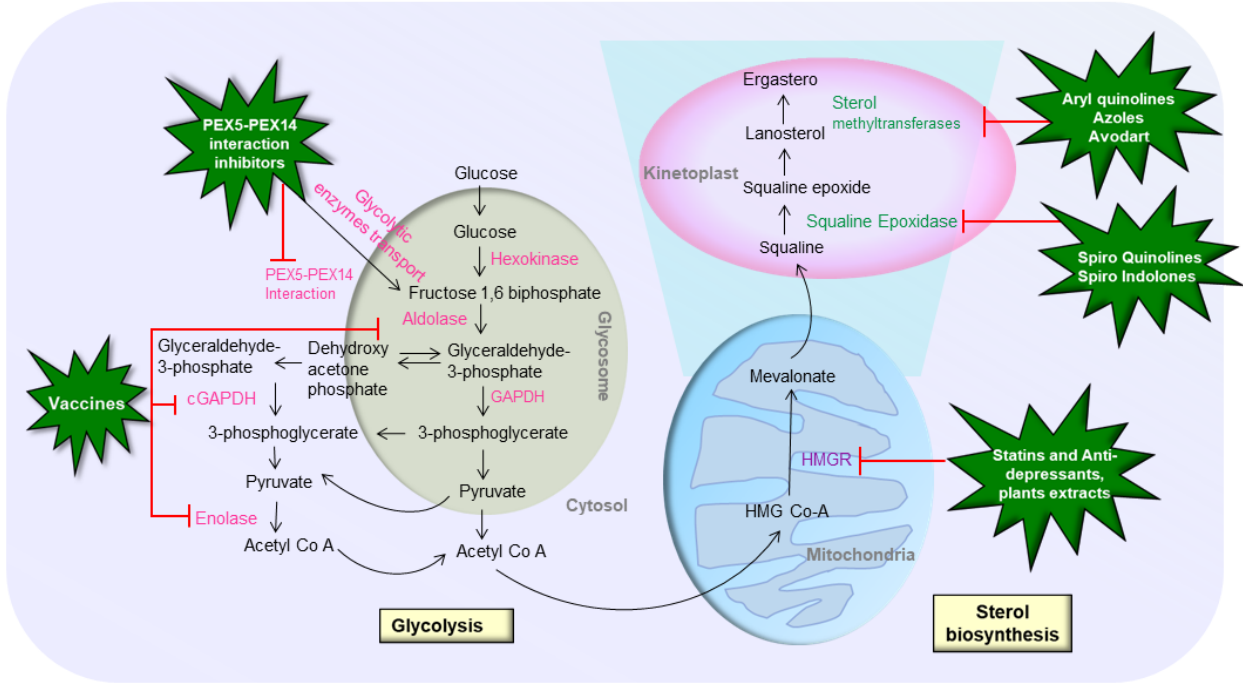
Figure 1. Potential drug targets and repurposed drugs against glycolysis and sterol biosynthesis pathways of Leishmania parasite. pathways of Leishmania